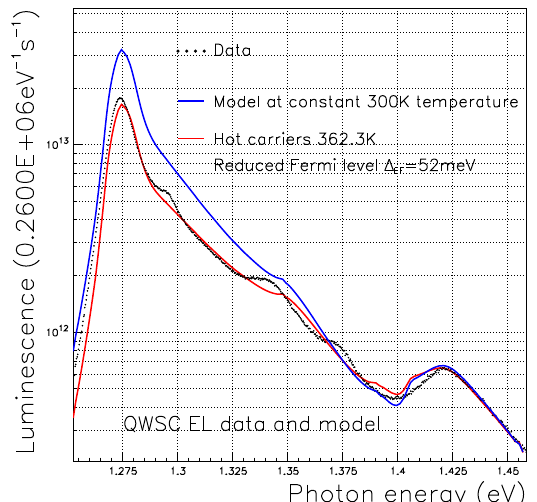
Fig. 3. Experimental (dots) and theoretical fi ts of a quantum well solar cell (QWSC) showing a good fi t at room temperature in the bulk (dark line) but a higher temperature needed for well luminescence (red